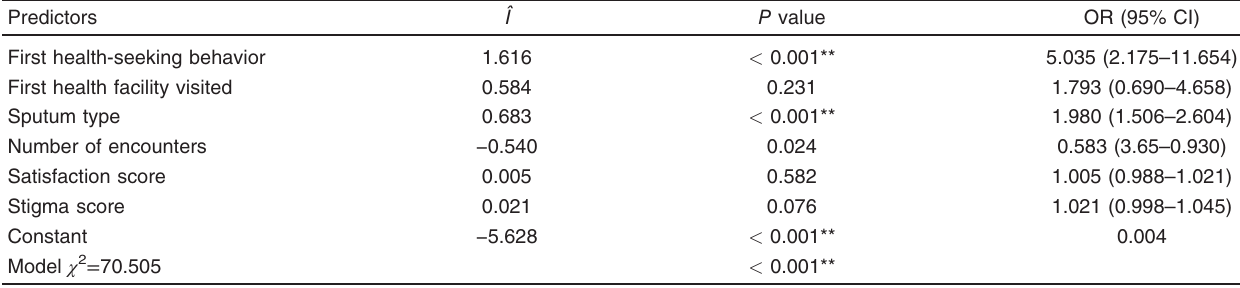
CI, confidence interval; OR, odds ratio. **Statistically significant at P value